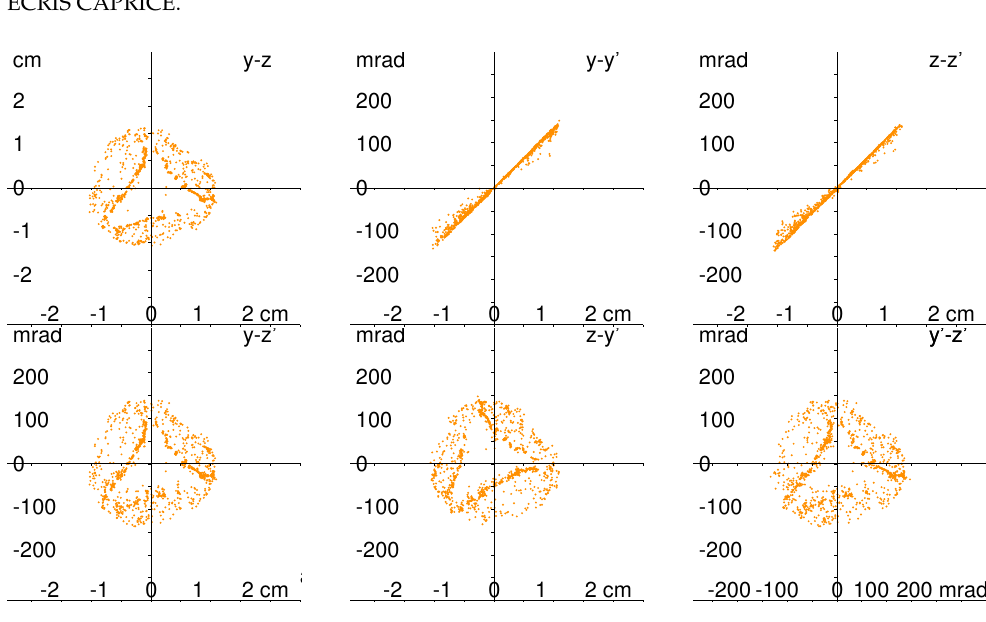
Figure 8. Different projections of the six-dimensional phase space. Same order as in Figure 7. Only one m / q ( 40 Ar 3 + ) is shown here. Only these ions are shown, initiated on a magnetic field line which passed through the extraction aperture and only on a fixed radius of 4mm. Simulation made for ECRIS HIISI